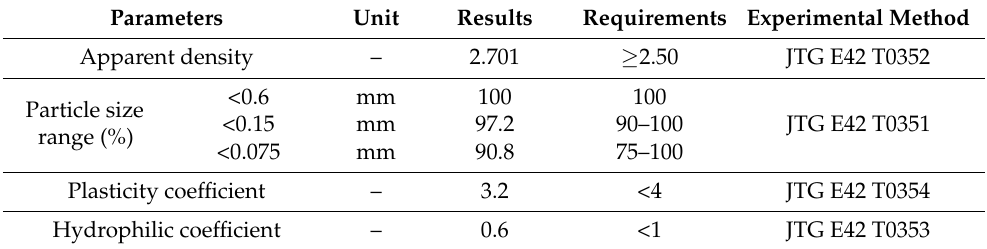
Table 5. Technical properties of mineral